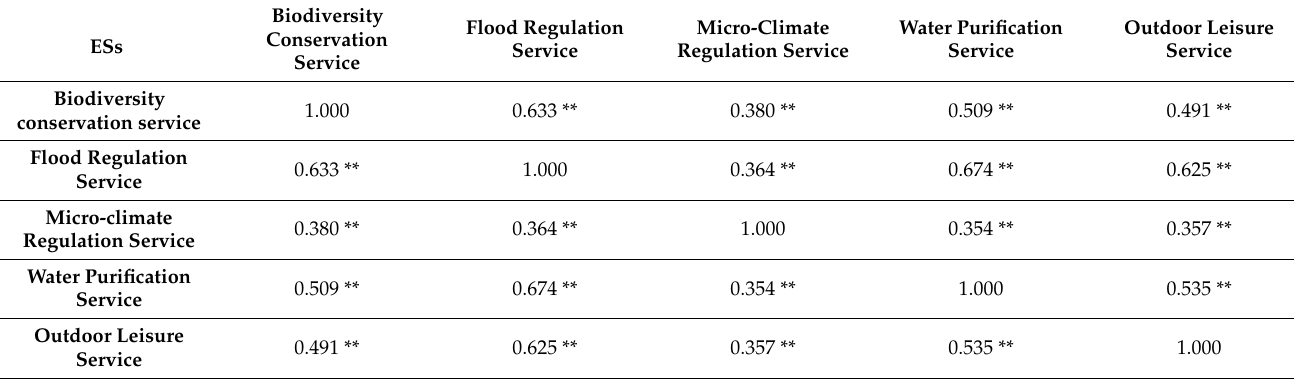
Table A5. Spearman’s rank correlation coefficient results between ES pairs provided by water linear spaces.